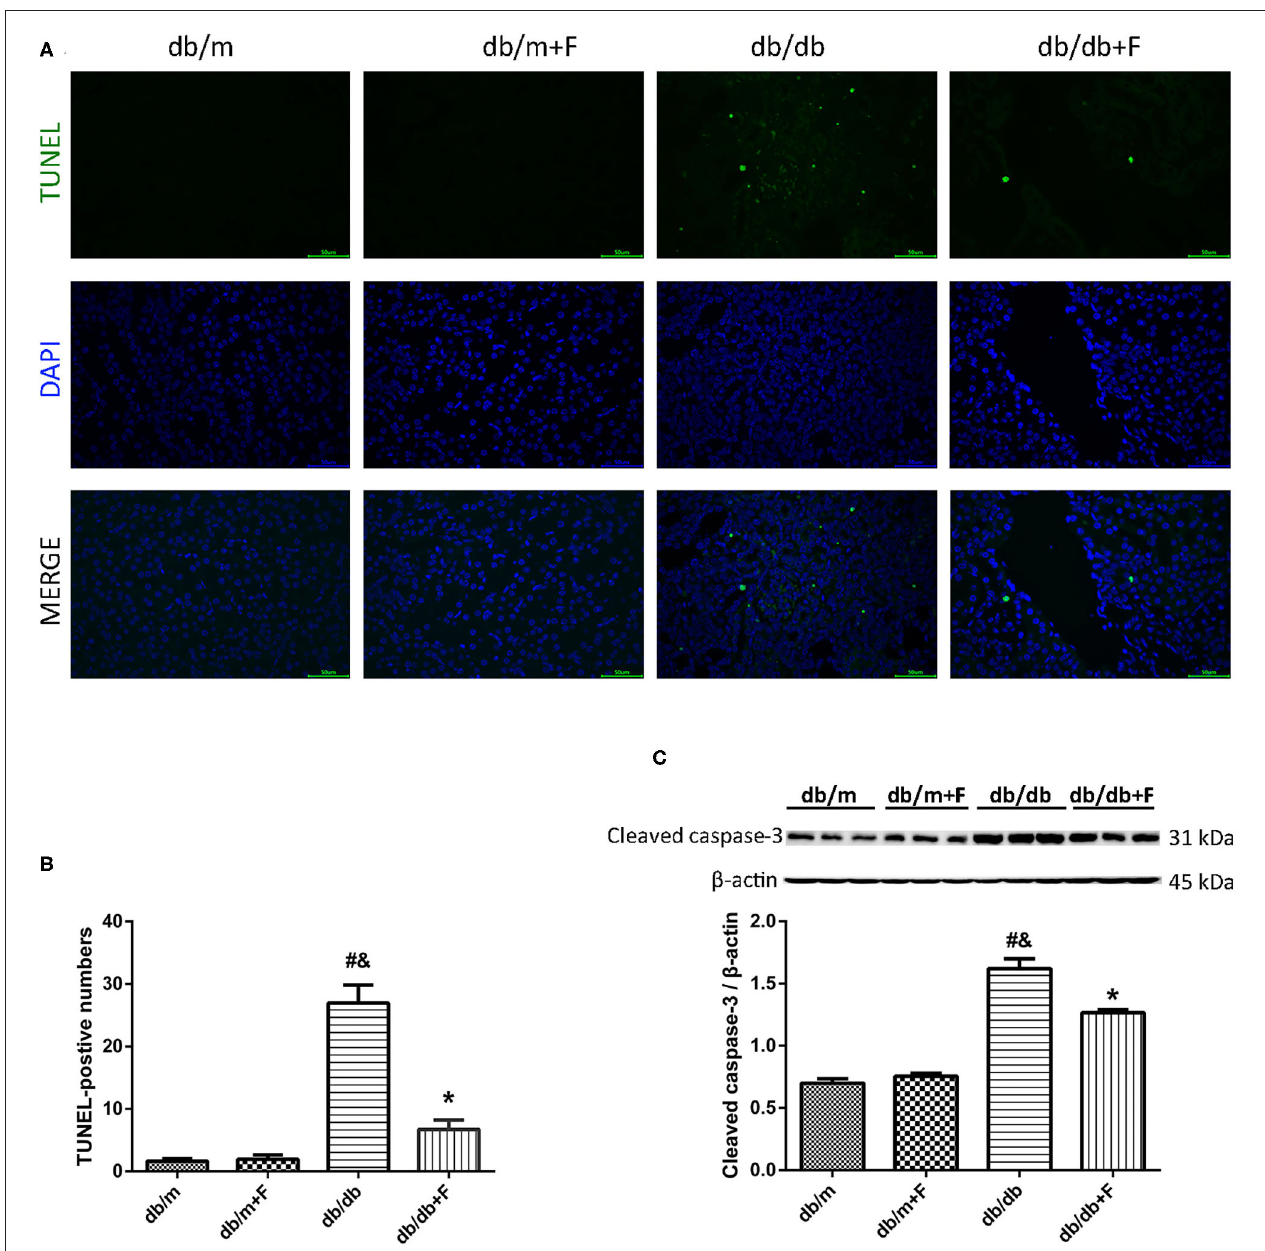
FIGURE 4 | Renal apoptosis in db/m, db/m + F, db/db, and db/db + F groups. (A,B) Representative photographs and quantification of renal apoptosis measured by TUNEL assay. (C) Representative photographs and quantification of cleaved caspase-3 in mouse kidneys detected by western blot. n = 6 mice/group. # P < 0.05 vs. db/m group; & P < 0.05 vs. db/m + F group; * P < 0.05 vs. db/db group. Db/m, db/m mice without fenofibrate treatment; db/m + F, db/m mice with fenofibrate treatment; db/db, db/db mice without fenofibrate treatment; db/db + F, db/db mice with fenofibrate treatment. Data are means ±